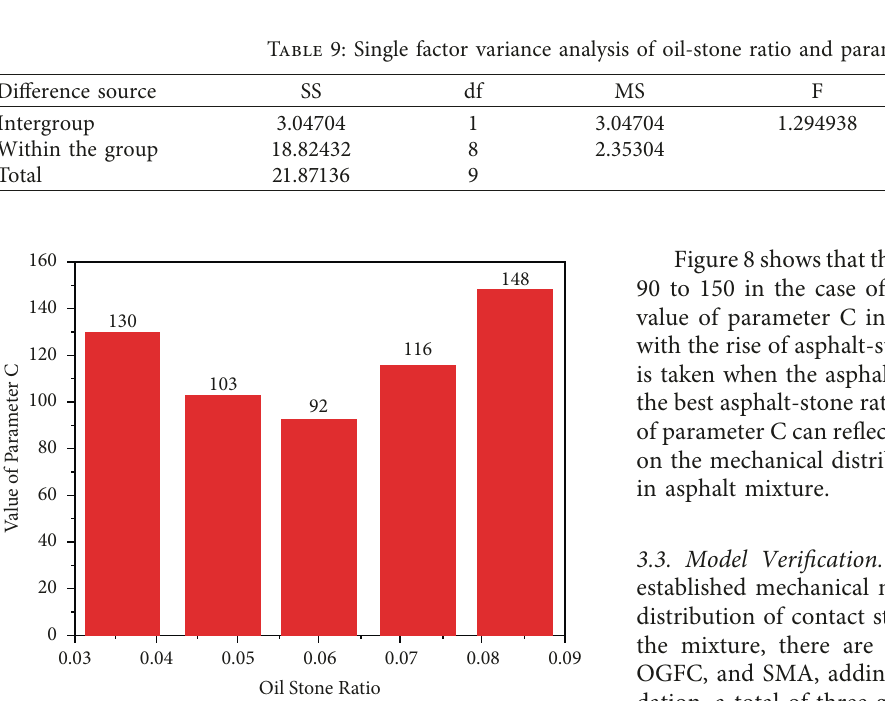
Figure 8: Variation diagram of parameter C with the ratio of oil to